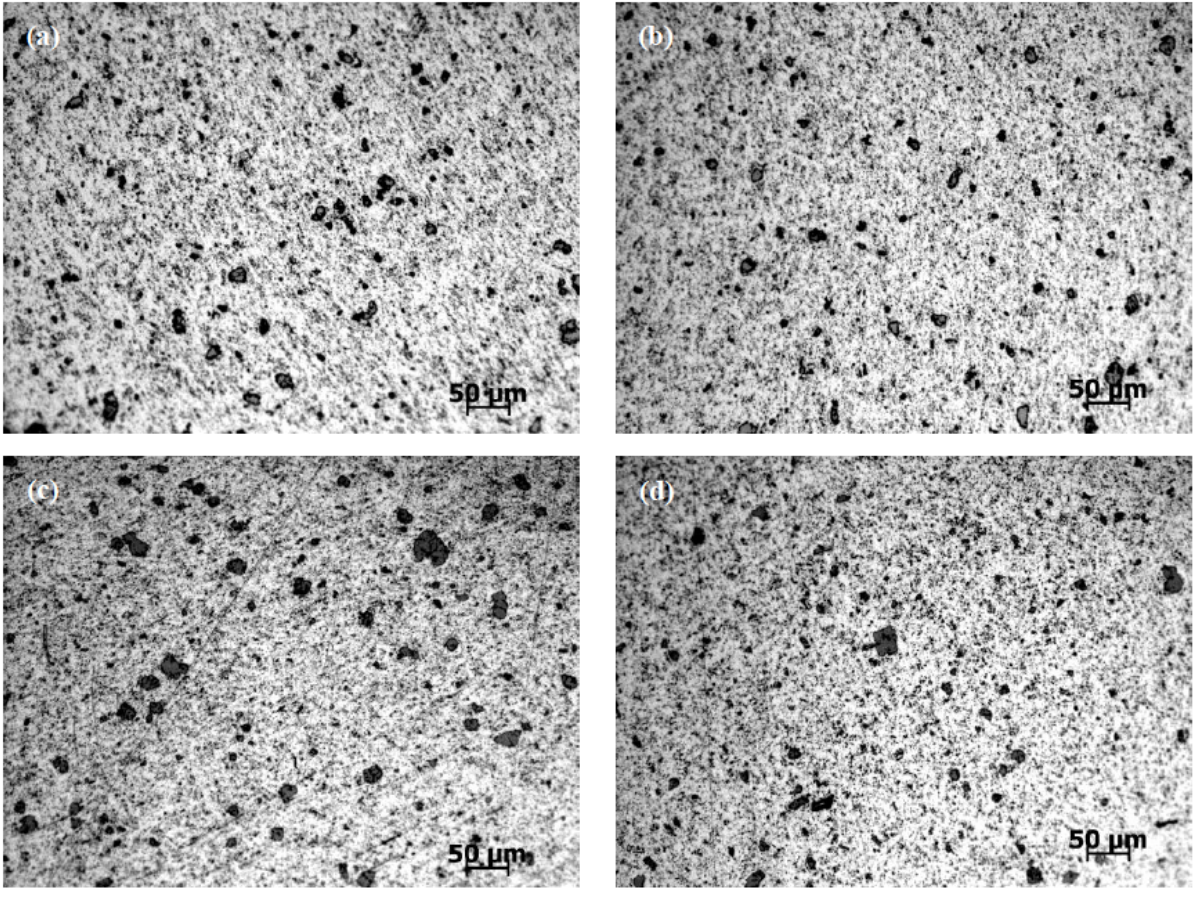
Figure 4: Horizontal microstructure metallography of AgSnO 2 NiO after extrusion and drawing × 200 (a) extrusion rod diameter of 6.0 mm; (b) wire drawing diameter of 5.2 mm; (c) wire drawing diameter of 3.4 mm; (d) wire drawing diameter of 1.5